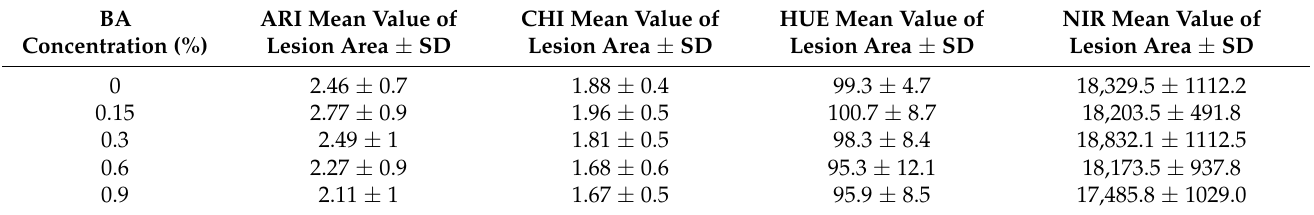
Table 2. Effect of BA on physiological parameters of tomato plants, 15 days post-application.